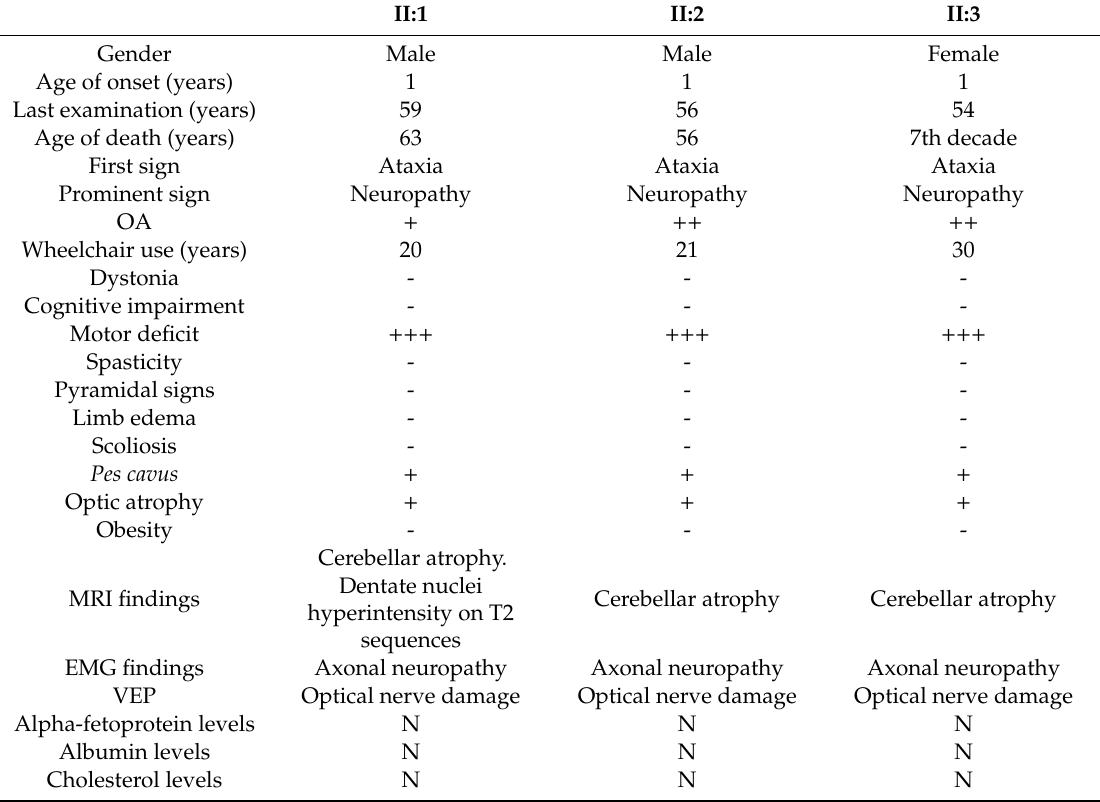
Table 1. The clinical, biochemical and imaging features of the patients carrying the MAG